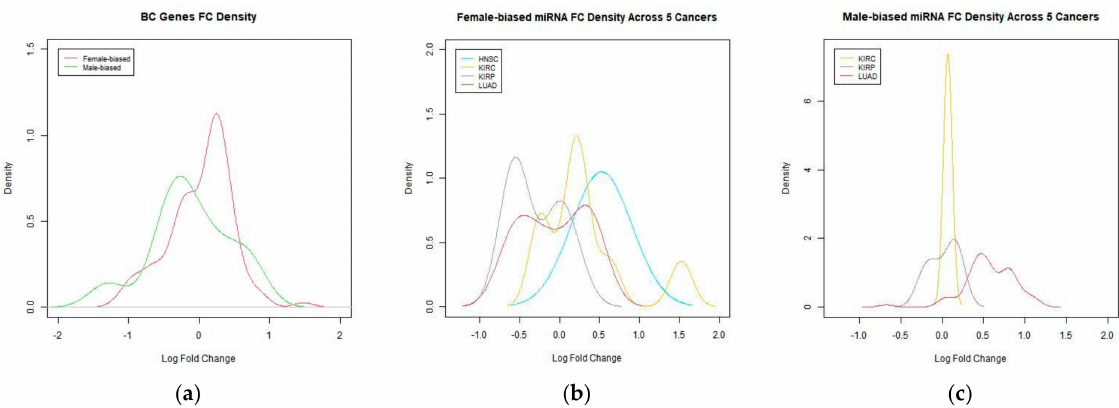
Figure 3. ( a ) FC density of genes in BC. ( b ) FC density of female-biased miRNA. ( c ) FC density of male-biased